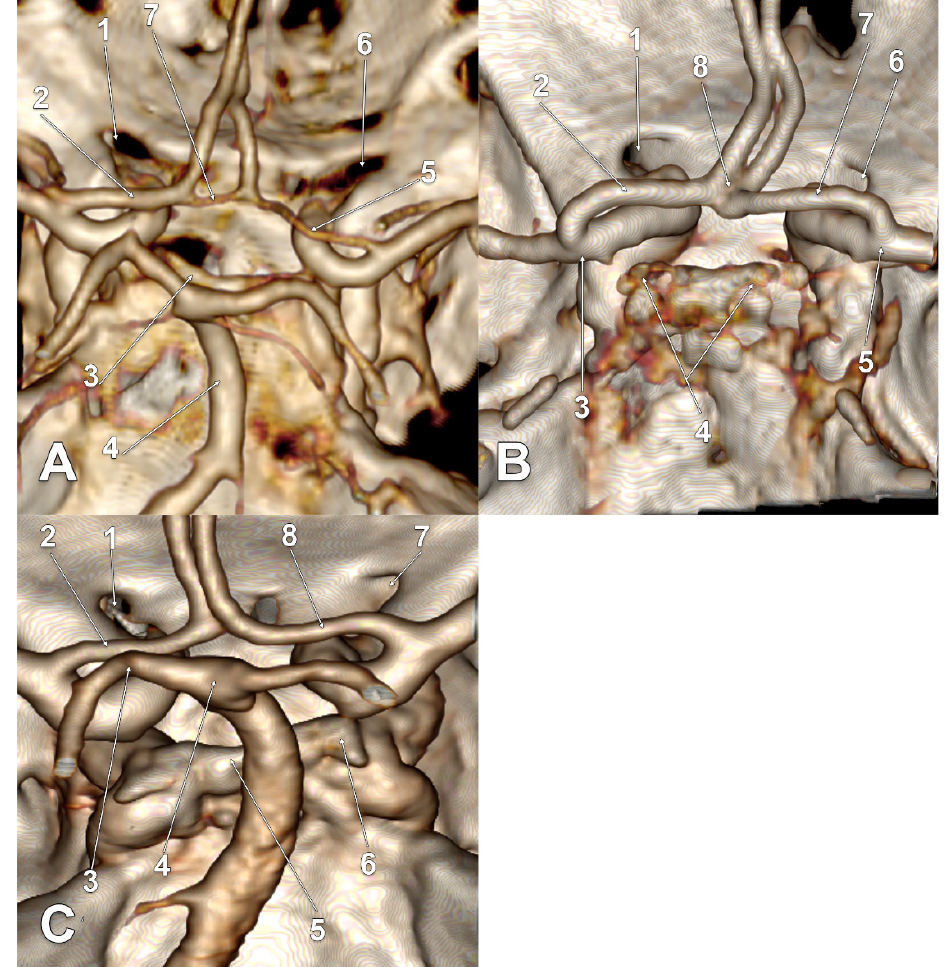
Figure 5. ( A ) Three-dimensional volume rendering of the skull base, posterosuperior view. Supraca- rotid infraoptic anterior cerebral arteries. Rotated anterior communicating artery. 1. Left optic canal; 2. A1 segment of the left anterior cerebral artery; 3. dorsum sellae; 4. basilar artery; 5. hypoplastic A1 segment of the right anterior cerebral artery; 6. right optic canal; 7. rotated anterior communicating artery. ( B ) Three-dimensional volume rendering of the skull base, posterosuperior view. Supracarotid infraoptic anterior cerebral arteries. 1. Left optic canal; 2. A1 segment of the left anterior cerebral artery; 3. left internal carotid artery bifurcation; 4. posterior clinoid processes; 5. right inter- nal carotid artery bifurcation; 6. right optic canal; 7. A1 segment of the right anterior cerebral artery; 8. fenestrated anterior communicating artery. ( C ) Three-dimensional volume rendering of the skull base, posterosuperior view. Supracarotid infraoptic anterior cerebral arteries. Rotated basilar artery bifurcation. 1. Left optic canal; 2. A1 segment of the left internal carotid artery; 3. left posterior cerebral artery, angled at 0.16 cm posterior to the ipsilateral A1 segment; 4. basilar artery bifurcation at 1.06 cm above the dorsum sellae; 5. dorsum sellae; 6. right posterior clinoid process; 7. right optic canal; 8. A1 segment of the right anterior cerebral artery.